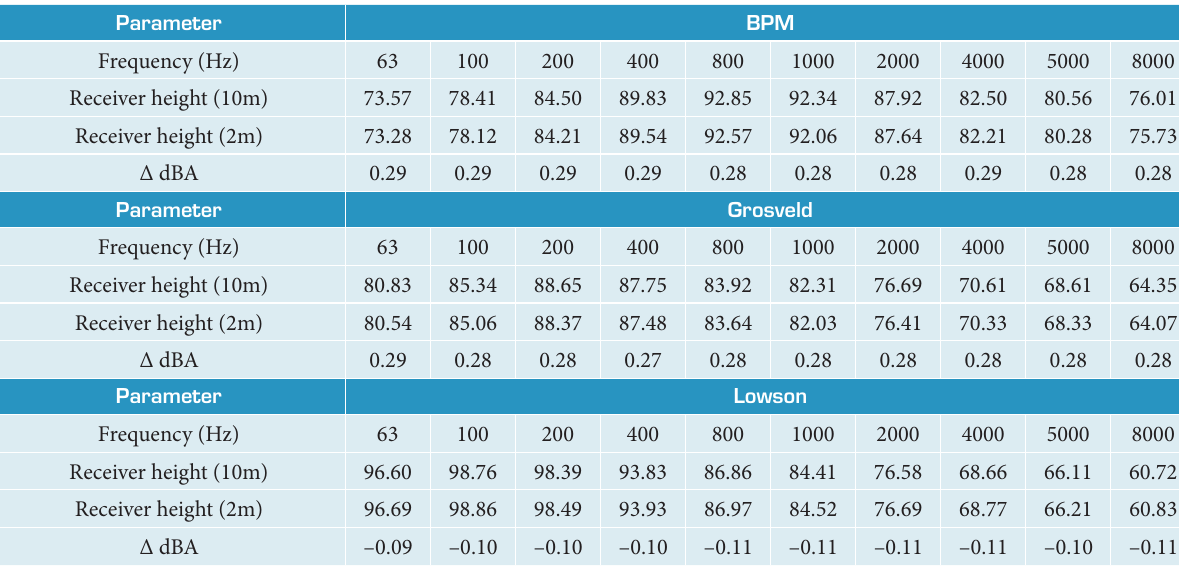
Table 1. Comparison of 1/3 rd octave A-weighted sound power level for trailing edge noise source of a 2 MW turbine due to change in receiver height from 10 m to 2 m between 63 Hz and 8 kHz using BPM, Grosveld and Lowson method. Receivers are located at ~120 m and downwind position, for both cases at wind speed of 8 m/s and at 15 RPM.